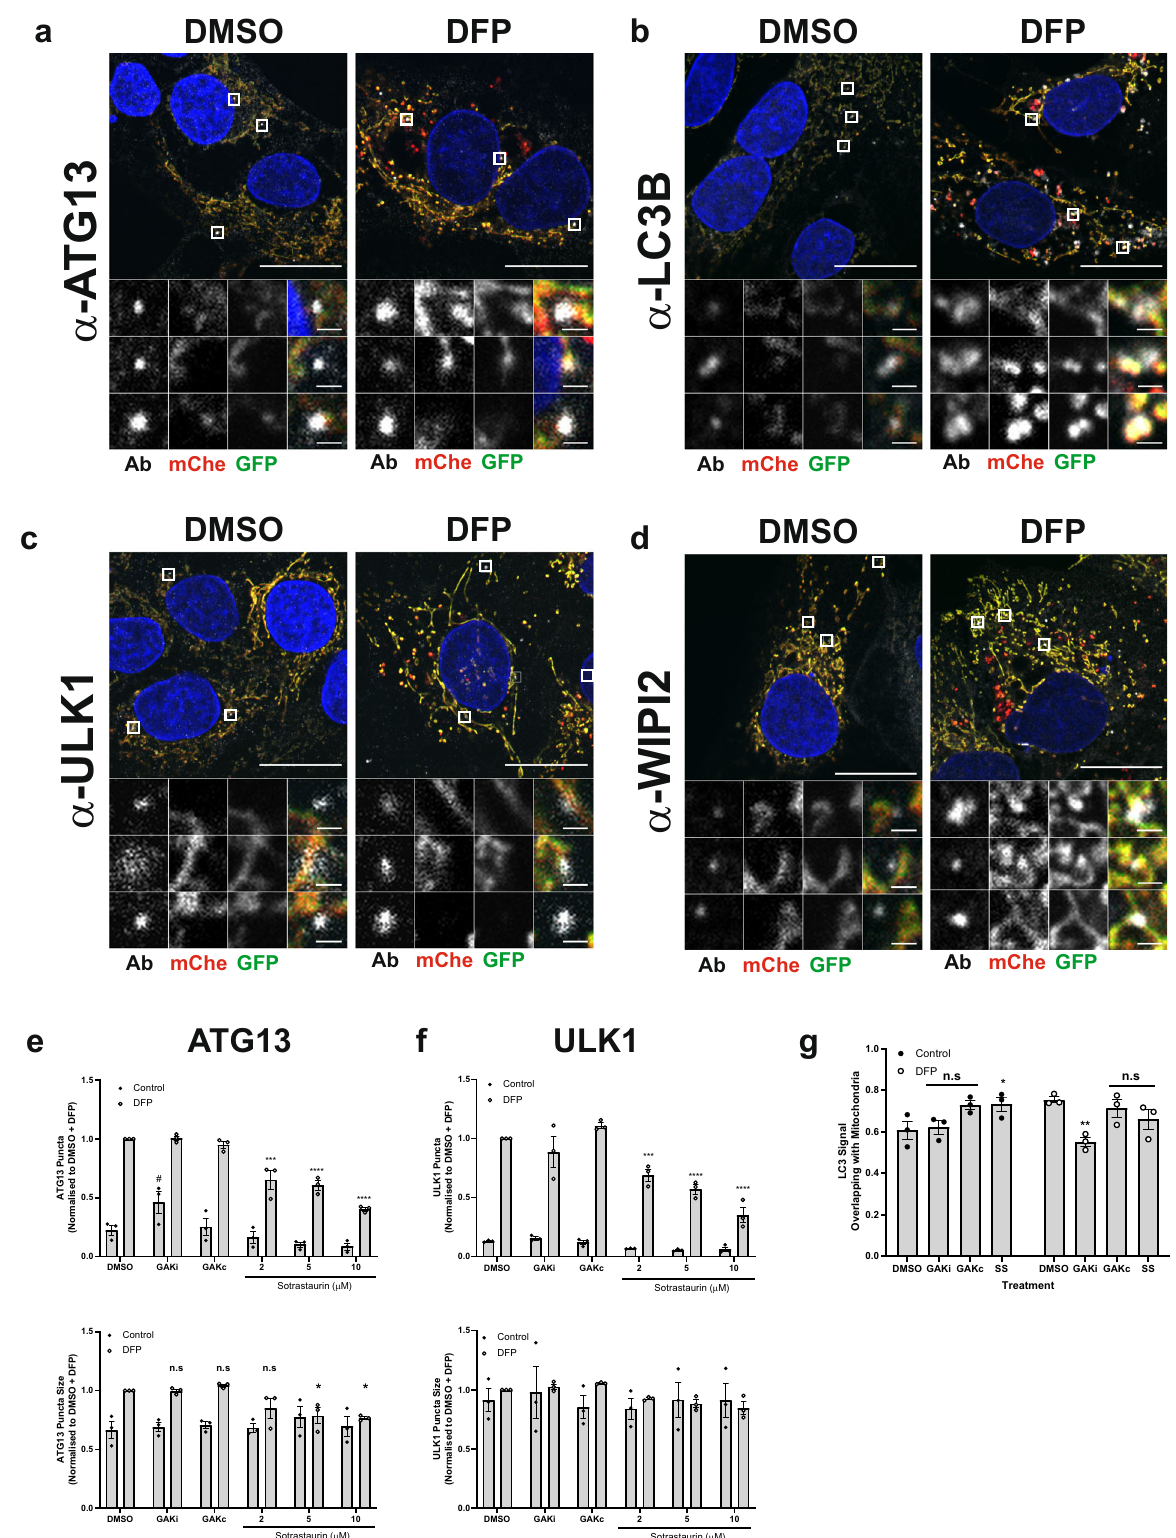
interactor of LC3 and signal for mitophagy that is dependent upon phospholipid scramblases such as PLSCR3 for bilayer movement 57,58 . PRKCD has been found to phosphorylate and regulate PLSCR3 activity during UV irradiation and is thereby another area that warrants further investigation under DFP- inducing conditions 26